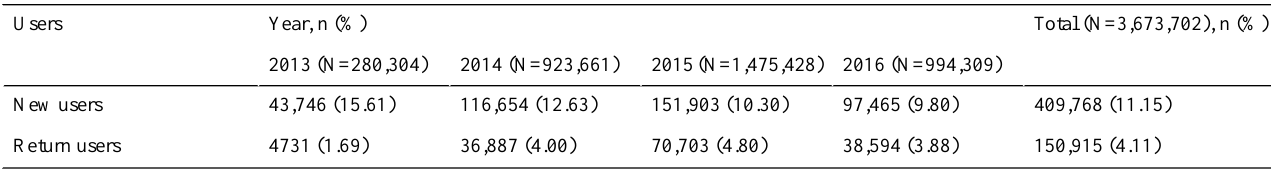
Table 3. Total interactions by new and return